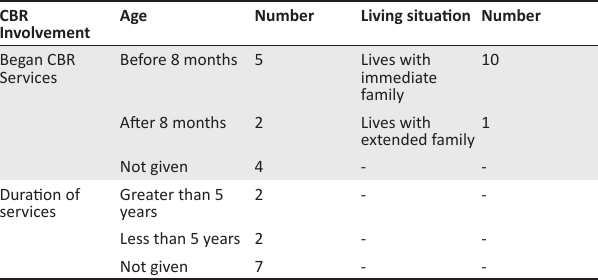
TABLE 1b : Demographics of the children with